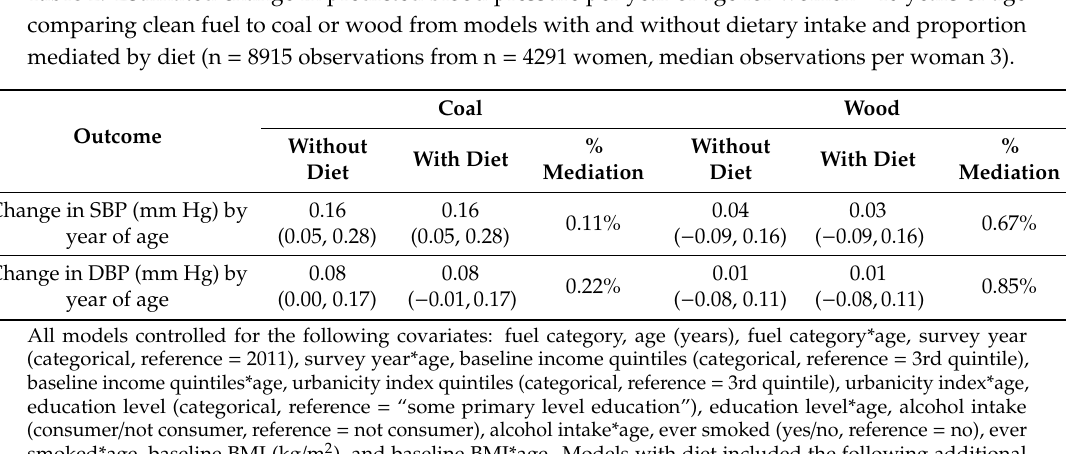
Table 2. Estimated change in predicted blood pressure per year of age for women < 40 years of age comparing clean fuel to coal or wood from models with and without dietary intake and proportion